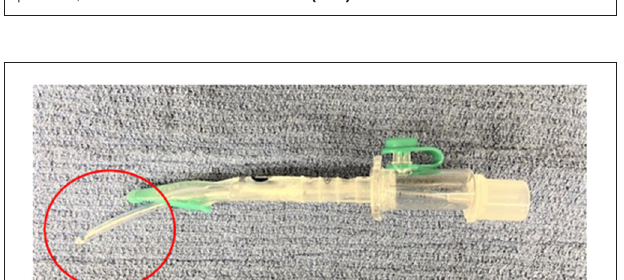
FIGURE 2 | Representative picture showing a 2.5mm internal diameter uncuffed ETT inserted through the v-gel ® airway channel (note